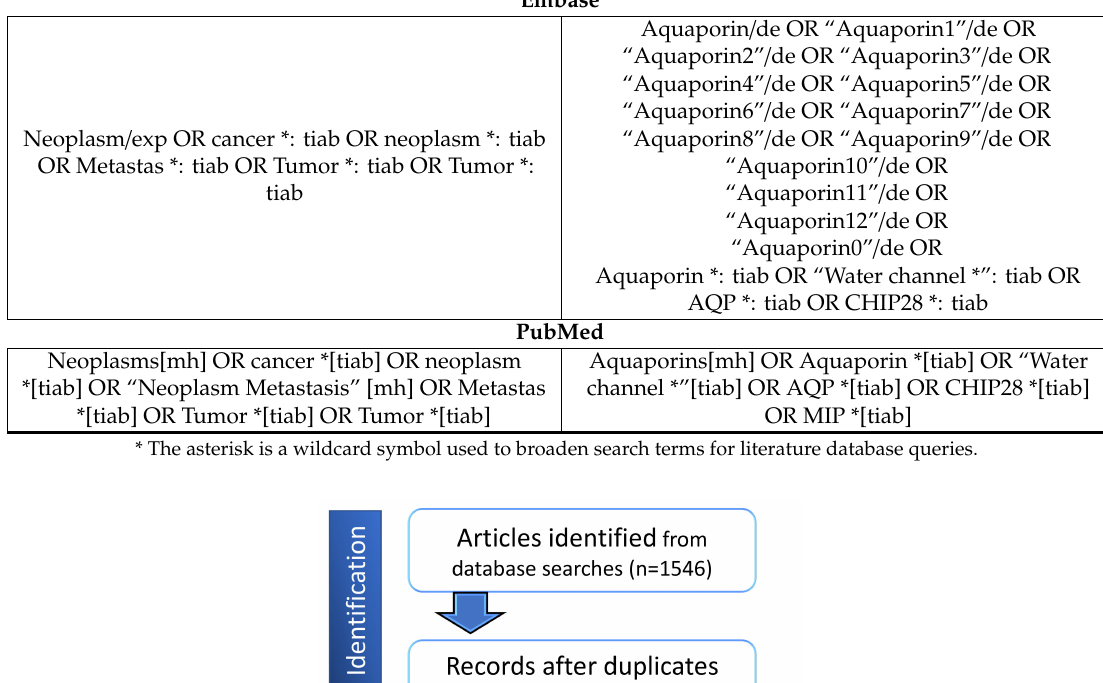
Table 1. Search terms used for data collection. (Searches combined the left and right sets with AND). Embase